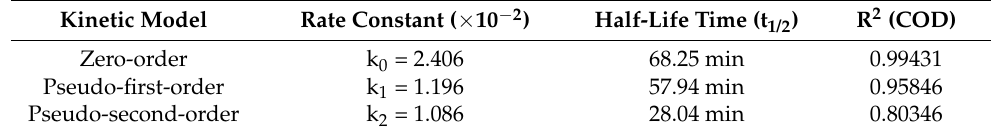
Figure 4. Linear fit plots for ( a ) zero-order, ( b ) pseudo-first-order (Arrows representing Data range), and ( c ) pseudo-second-order kinetics for RhB dye degradation. Table 2. Kinetic parameters for the degradation of RhB dye using CdO-ZnO nanocomposites.